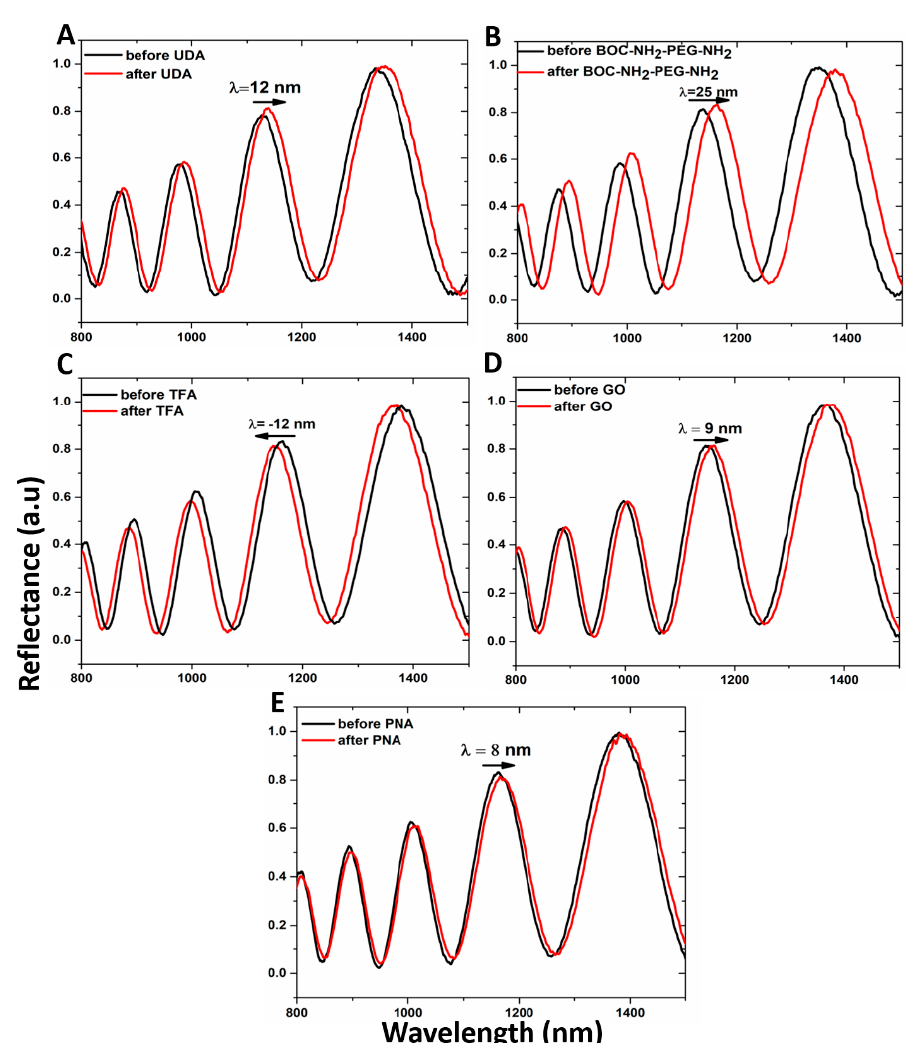
Figure 4. Reflectivity spectra of PSi ( A ) before (black line) and after (red line) UDA passivation, ( B ) before (black line) and after (red line) PEGylation with BOC-NH 2 -PEG-NH 2 , ( C ) before (black line) and after (red line) deprotection of amino group by TFA treatment, ( D ) before (black line) and after (red line) GO infiltration, ( E ) before (black line) and after (red line) PNA immobilization.